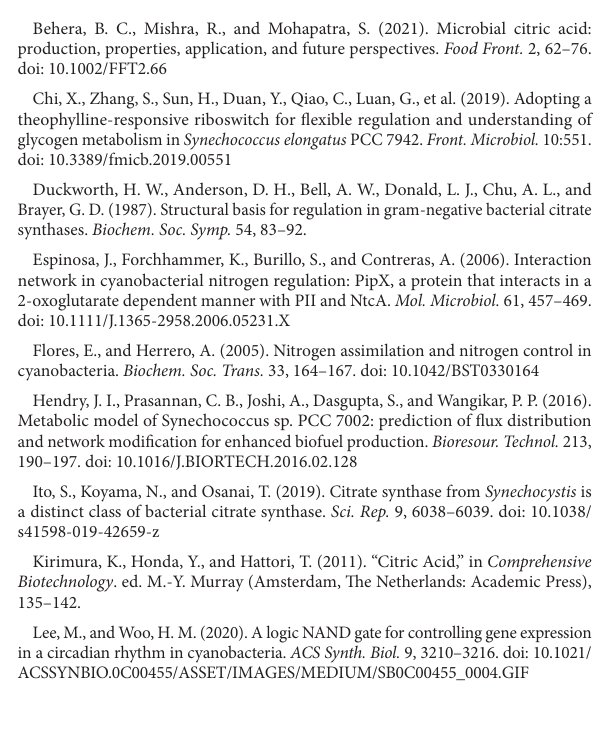
SUPPLEMENTARY FIGURE S1 Induced mutations on theophylline aptamer. (A) Alignment of TS02834 theophylline riboswitch region after 10 days culturing in the absence of theophylline, without or with glutamate supplementation. (B) Secondary mRNA structure of original (left) and mutated (right) theophylline riboswitch aptamer. Structures simulated using the mFold tool in OligoAnalyzer package. Red lines mark RBS sequence. SUPPLEMENTARY FIGURE S2 Biological variability in citrate production between citrate producing strains. (A) Citrate production in three independent production strains in the absence of theophylline and glutamate supplementation. (B) Citrate production in three independent production strains in the absence of theophylline and no glutamate supplementation. SUPPLEMENTARY TABLE S1 List of primers used in this